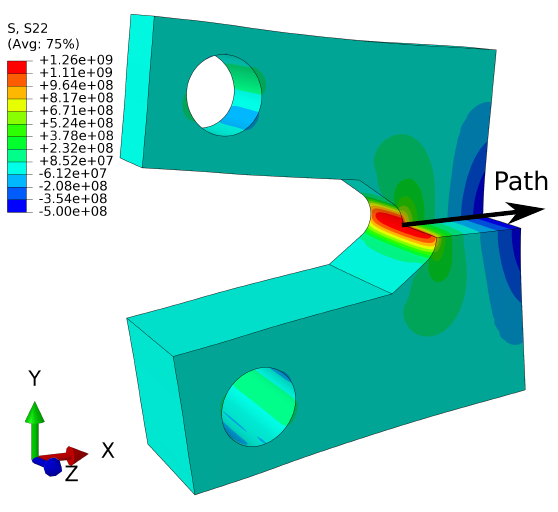
Figure 5. Path at which the y -component stress profile is extracted from a linear elastic finite element analysis; image from Ref. [6].